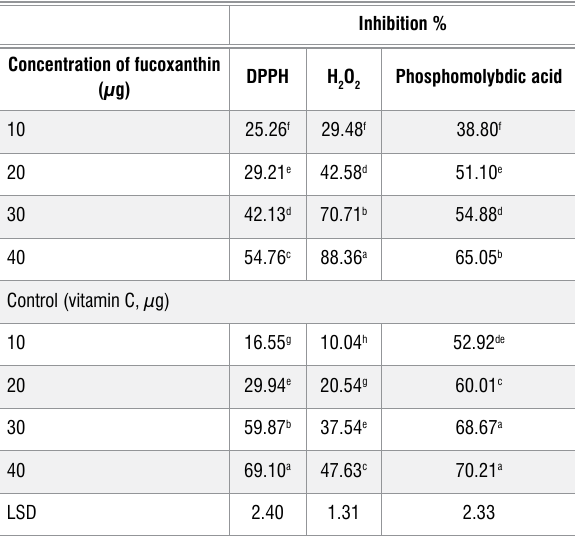
Table 2: Antioxidant activity of crude fucoxanthin from Dilophys fasciola against DPPH, H O and phosphomolybdic acid 2 2